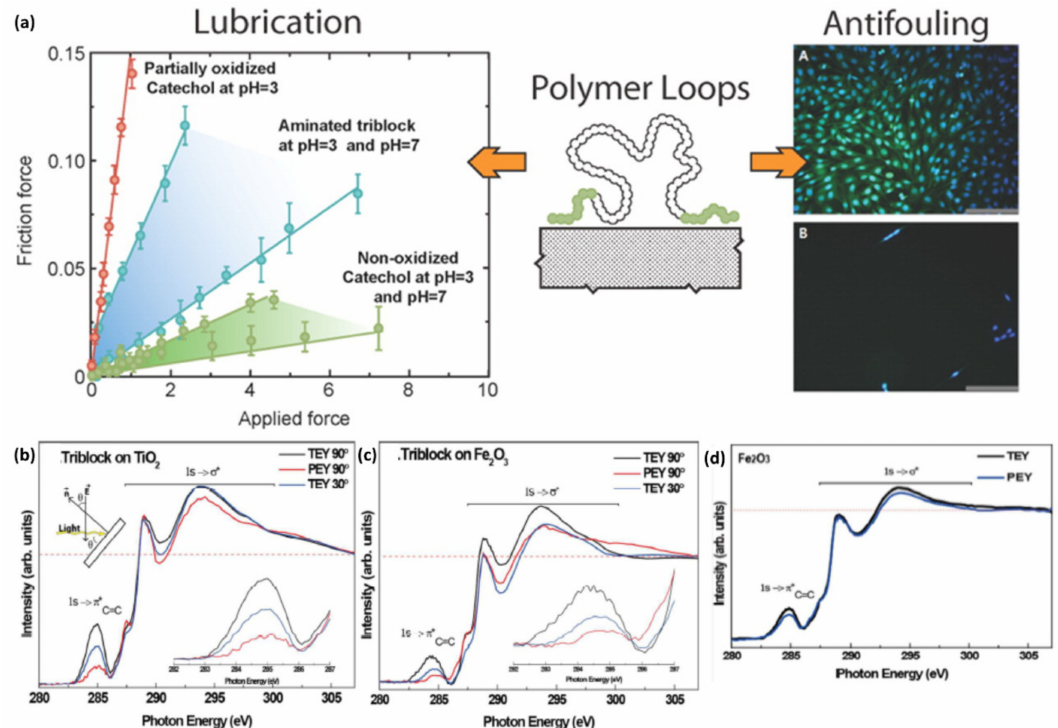
Figure 18. ( a ) Friction force of the triblock copolymer chain with di ff erent functional groups (left), the schematic showing triblock copolymer adsorbed onto the surface of mica (middle), and optical microscopic images (right) showing the adhesion of cells to the bare glass (top) and glass coated with a catechol-functional-triblock copolymer (bottom). NEXAFS spectra of ( b ) TiO 2 and ( c ) Fe 2 O 3 substrates adsorbing the triblock copolymer (partial electron yield (PEY) mode at incidence angles of 90 ◦ and 30 ◦ ). ( d ) NEXAFS spectra in total electron yield (TEY) and PEY mode of the triblock copolymer coated on Fe 2 O 3 surface (Reproduced with permission from Reference [136]; Copyright (2016) American Chemical